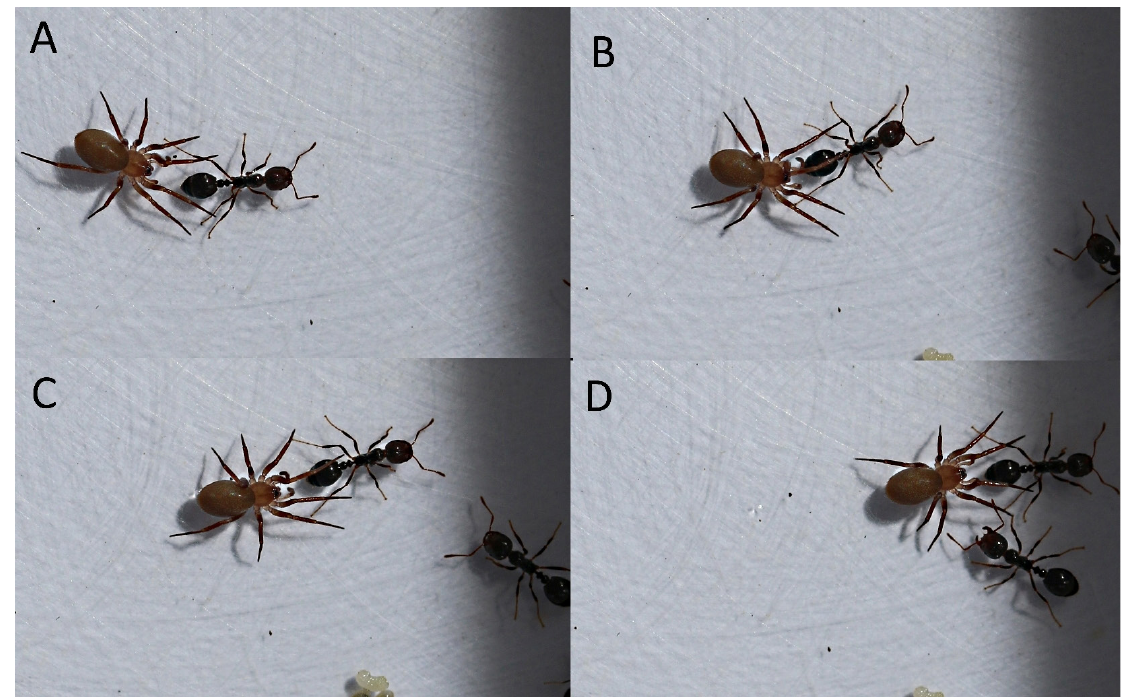
Fig 1 . Attacobius lavape female closely following and touching the Solenopsis saevissima workers in a colony maintained in laboratory. A-D: sequence of persecution